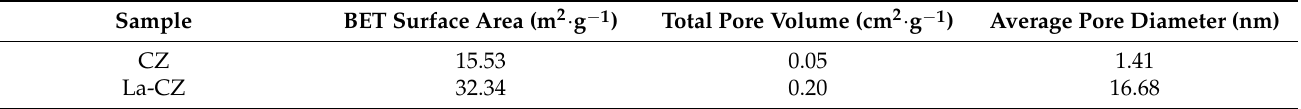
Table 1. The BET surface area, total pore volume, and average pore diameter of La-CZ and CZ.